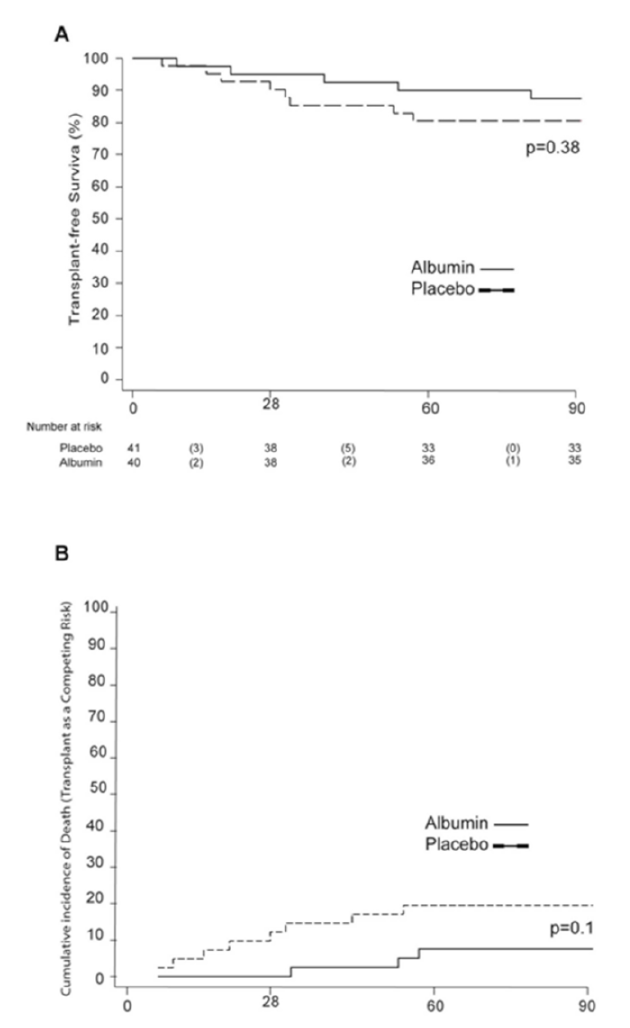
Figure 2. Transplant-free survival and cumulative incidence of death with transplant as a competing risk. ( A ) Kaplan–Meier estimates of transplant-free survival at 90 days. ( B ) The 90-day cumulative incidence of death with transplant as a competing